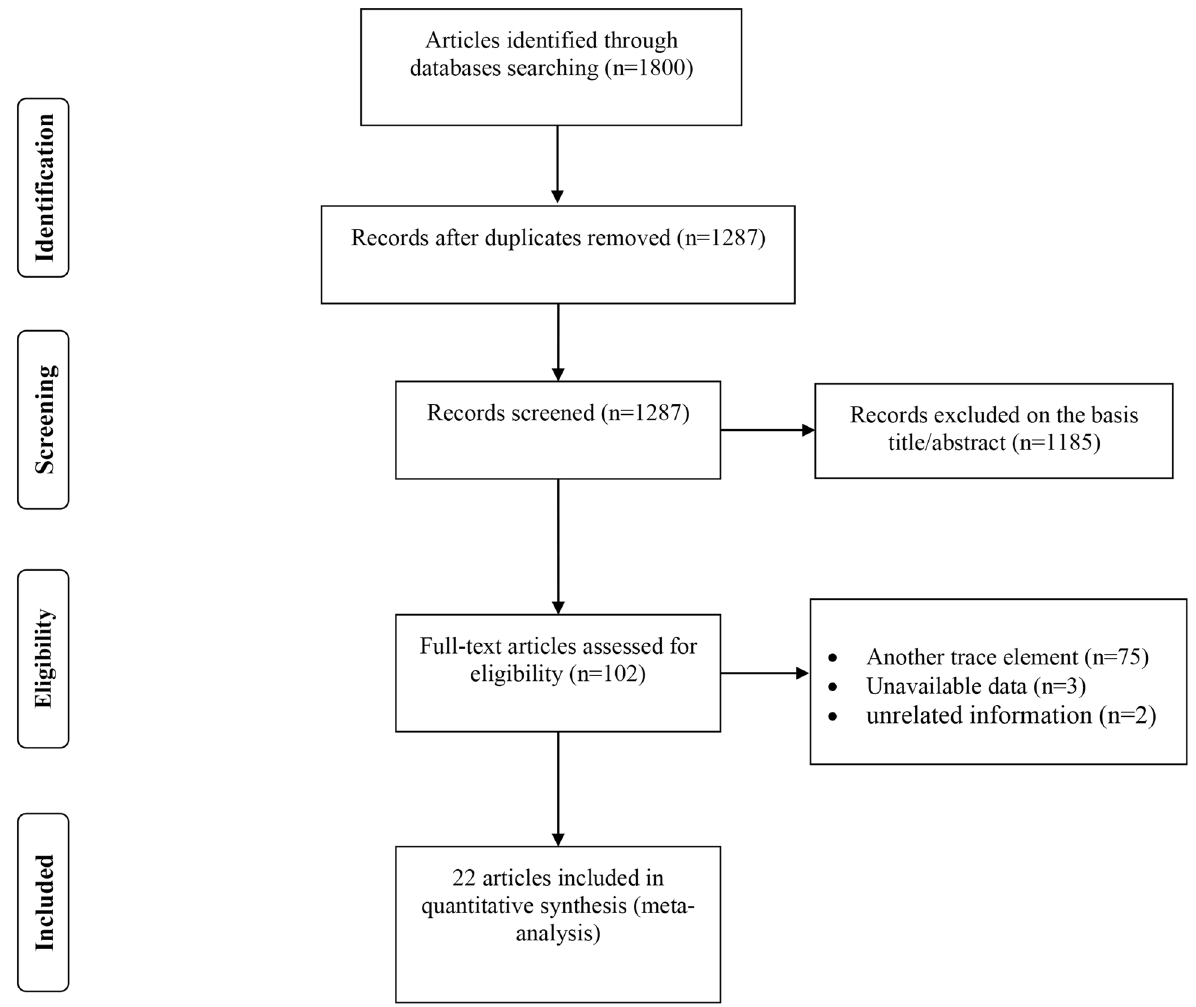
Figure 1. PRISMA flowchart describing the study’s systematic literature search and study